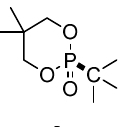
Figure 8. Cyclic tert -butyl phosphonate 9 .